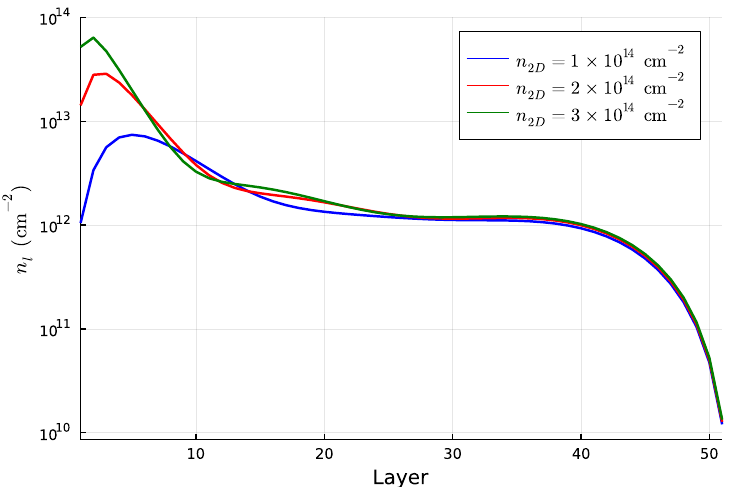
Figure 7. Electron density as a function of the layer position for every benchmark value of n 2 D in the presence of Coulomb